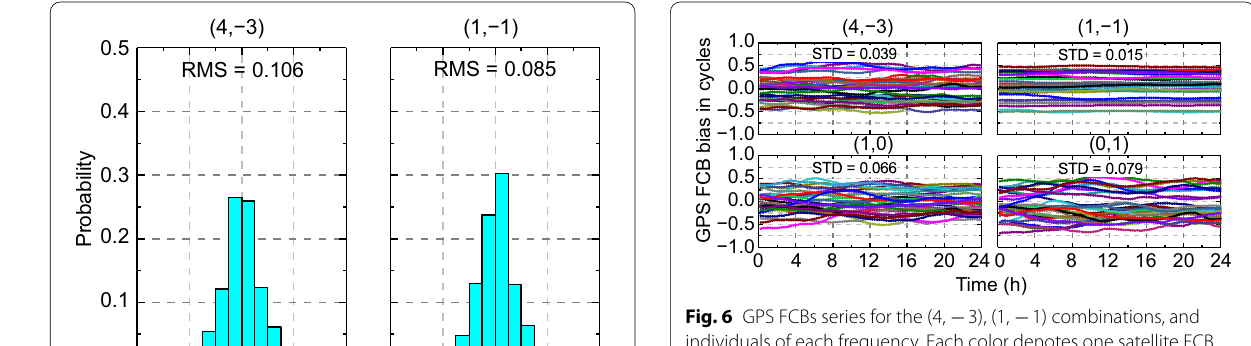
3), (1, 1) combinations, and − −